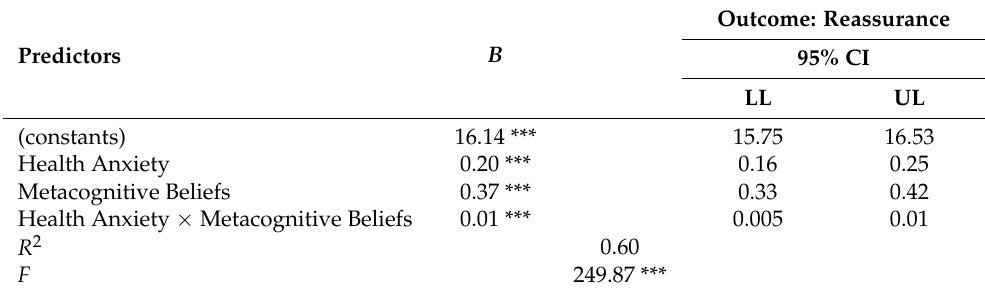
Table 8. Moderation of metacognitive beliefs between health anxiety and reassurance (cyberchondria construct) ( N = 500).